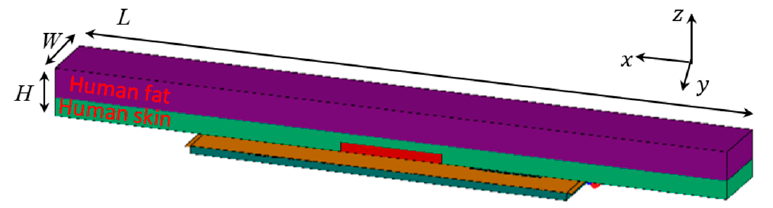
Figure 7. Illustration of the simulation setup for skin tumor evaluation in FEKO.